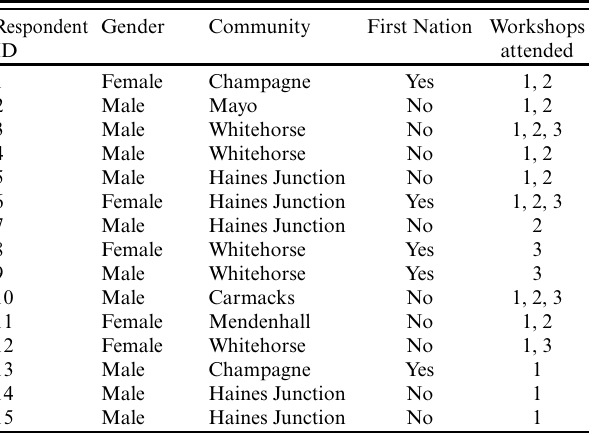
Table 1 . Participant demographics and